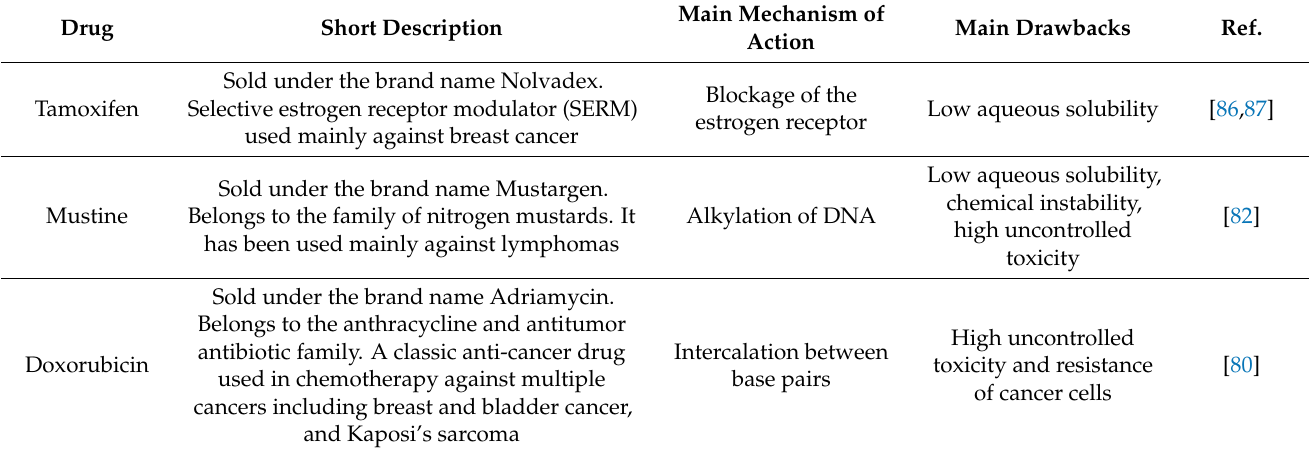
Table 2. Summary of the anticancer drugs utilized within theranostic structures. Their mechanisms of action and the most important drawbacks are also